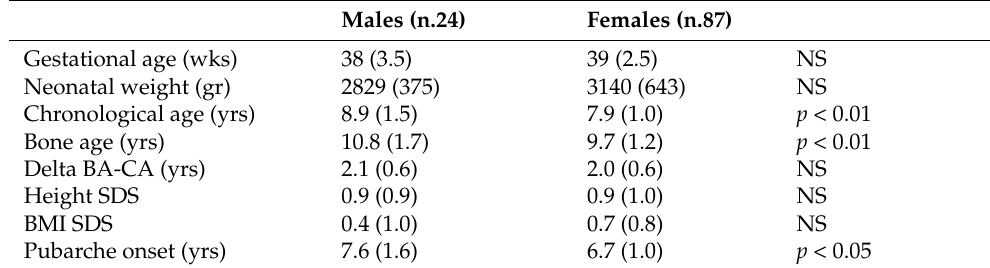
Table 1. Clinical and anthropometric features at first evaluation [mean (SD)]. NS: Non-Significant. Males